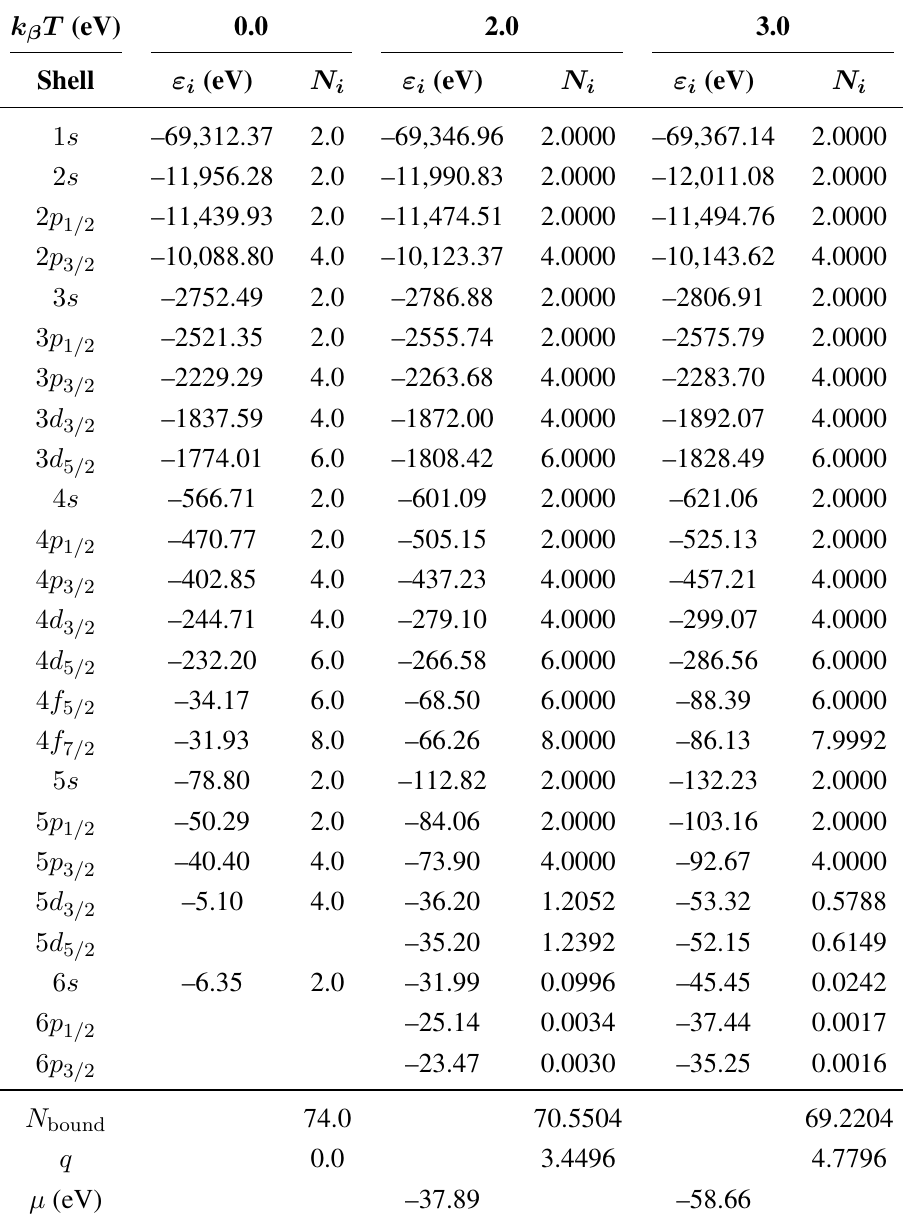
and level populations N i